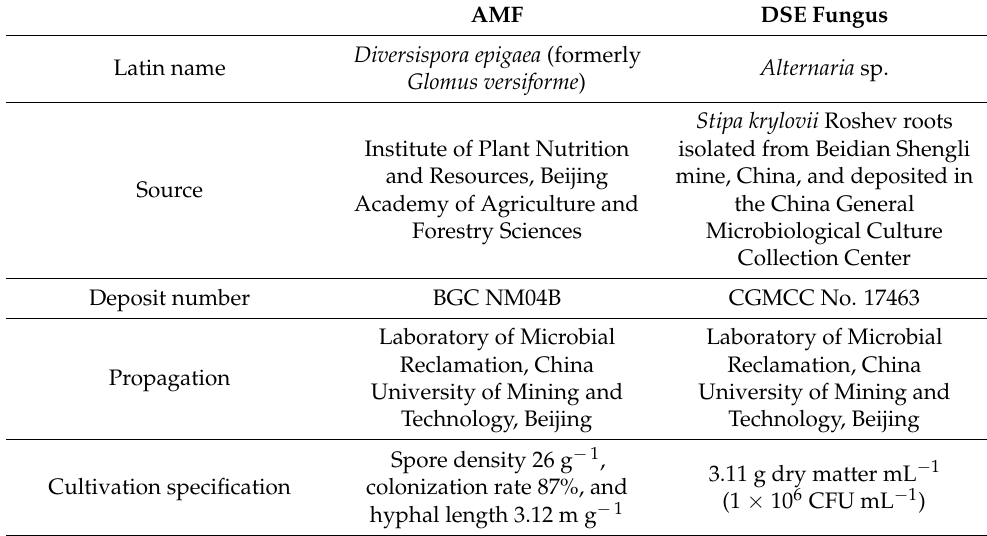
Table 1. Arbuscular mycorrhizal fungus (AMF) and dark septate endophytic (DSE) fungus, as used in the